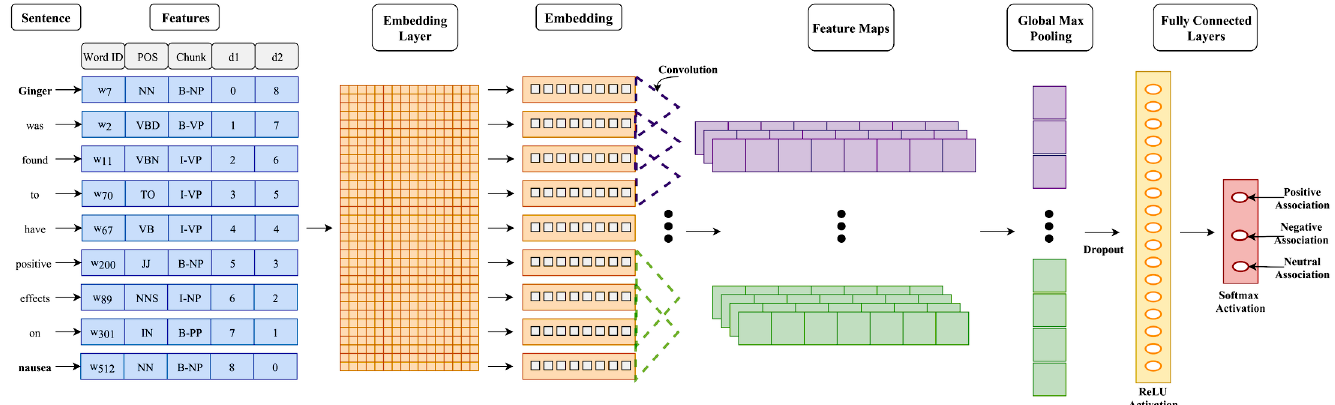
Fig 9. Architecture of the Convolutional Neural Network. Illustration of the convolutional neural network model utilizing word, position, part of speech and chunk embeddings.